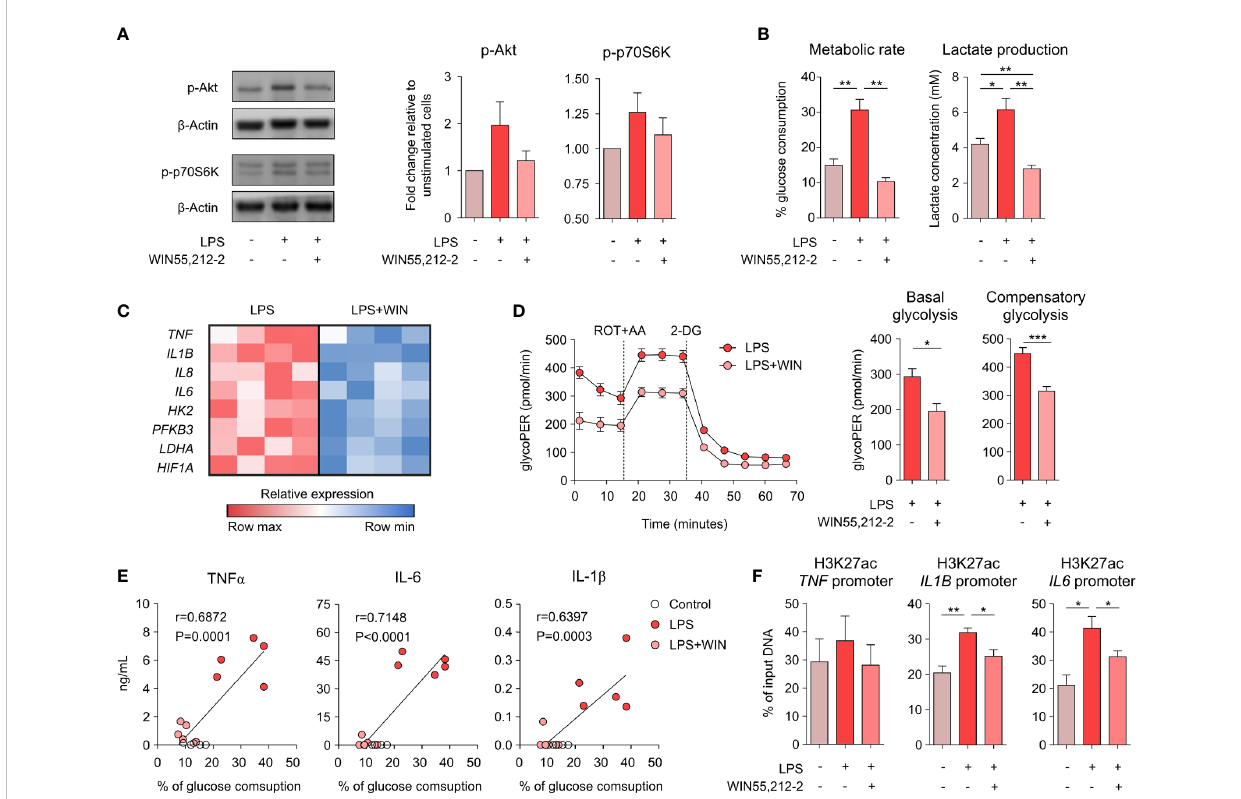
FIGURE 3 WIN55,212-2 impairs the metabolic and epigenetic reprogramming induced by LPS in human macrophages. (A) Representative western blot (left) and densitometric quanti fi cation (right) of GM-M F s stimulated with medium, LPS (10 ng/mL) or LPS plus WIN55,212-2 (10 µM). The graph shows combined results from 30 and 60 min of stimulation (n=6 independent experiments with 4 different donors). (B) Percentage of glucose consumption and lactate concentration measured from cell-free supernatants of GM-M F s stimulated with medium, LPS (10 ng/mL) or LPS plus WIN55,212-2 (10 m M) (n=6). (C) Heat map showing the expression of pro-in fl ammatory cytokine and glycolysis-related genes in GM-M F s stimulated with LPS or LPS+WIN55,212-2 during 4h (n=4). (D) Real-time analysis of glycolytic Proton Ef fl ux Rate (glycoPER) of GM-M F s after 18h stimulation with LPS or LPS plus WIN55,212-2 (LPS+WIN) at basal conditions and after sequential addition of rotenone plus antimycin A (ROT+AA) and 2- deoxyglucose (2-DG). Graphs representing basal and compensatory glycolysis are displayed (right) (n=6 of two independent experiments). (E) Correlation between TNF a , IL-1 b or IL-6 with the % of glucose consumption of GM-M F s stimulated with medium (Control), LPS or LPS+WIN (n=5). (F) Analysis of H3K27ac histone modi fi cations at the promoter sites of the indicated genes in GM-M F s stimulated with medium, LPS or LPS plus WIN55,212-2 for 4h (n=5). Values are shown as mean ± SEM. Statistical signi fi cance was determined by One-way ANOVA (B, F) Unpaired t test (D) or Spearman test (E) . *P<0.05, **P<0.01 and